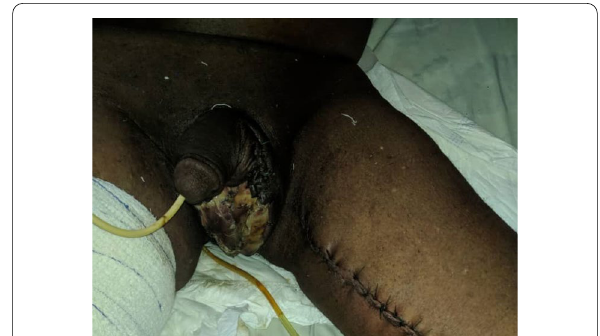
Fig. 7 The necrotic skin graft following the retraction of the muscle flap